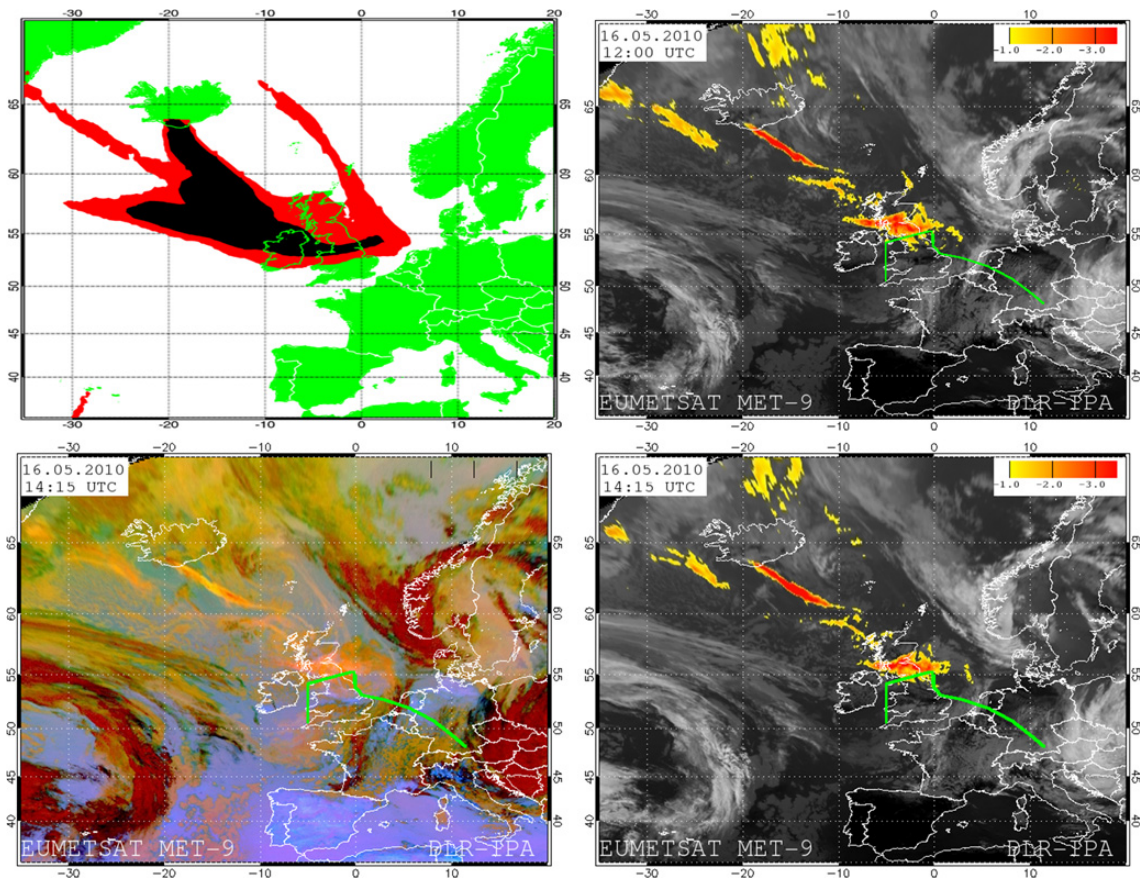
Fig. 14. Comparison of VAAC prediction for flight levels 0–6km, issued 12:00UTC 16 May 2010 (top left) together with various ash detection results based on Meteosat-8 SEVIRI data, in Mercator projection, including the Falcon flight path (green curve). Top: 12:00UTC 16 May 2010; bottom: 14:15UTC 16 May 2010. Right panels: Ash product based on brightness temperature difference 10.8µm–12.0µm (color bar, in Kelvin) in combination of smoothing and an upper threshold of − 1.0K. The grayscale background represents the 10.8µm brightness temperature. Bottom left: Dust composite, as described in text. Ash appears orange in this